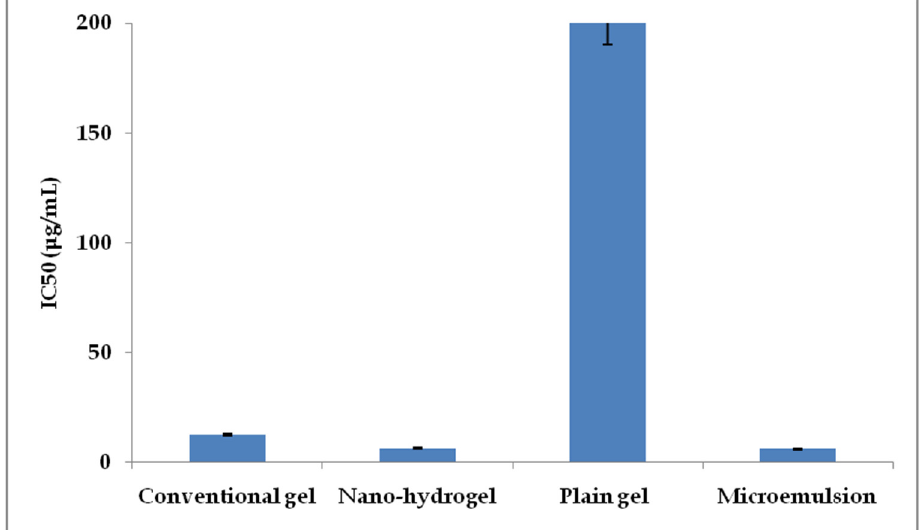
Figure 10. IC 50 values of the tested formulations against MCF-7 cell lines .